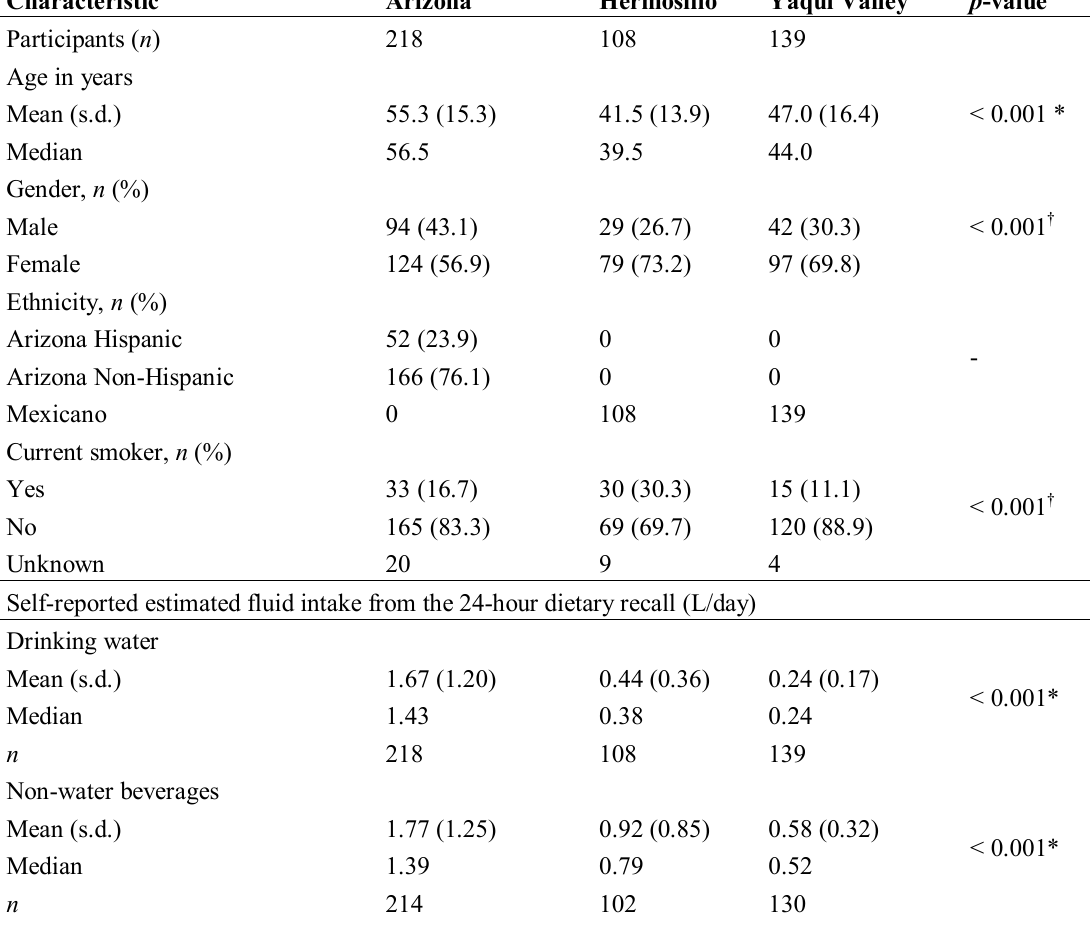
Table 3. Demographic and Lifestyle Characteristics of BAsES Participants by